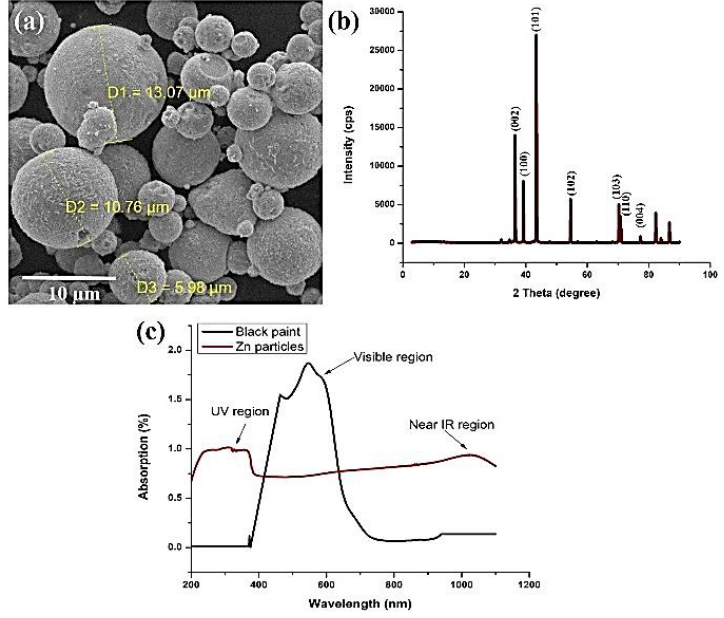
Figure 4. ( a ) SEM micrograph, ( b ) XRD pattern, and ( c ) UV-Vis spectra of as-received Zn powder and black paint (matrix). Coatings 2021 , 11 , x FOR PEER REVIEW